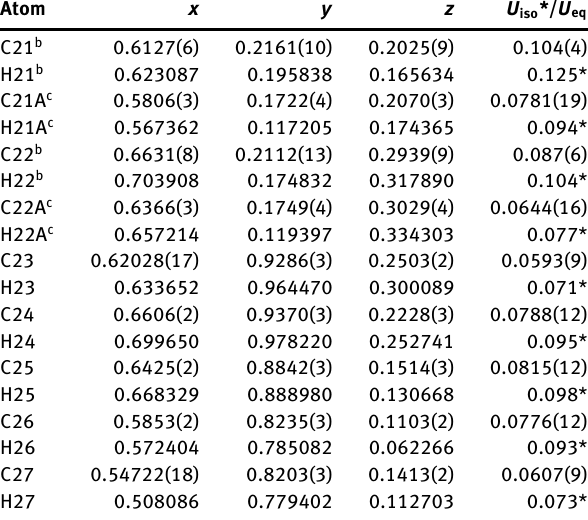
Table 2: Fractional atomic coordinates and isotropic or equivalent isotropic displacement parameters (Å 2